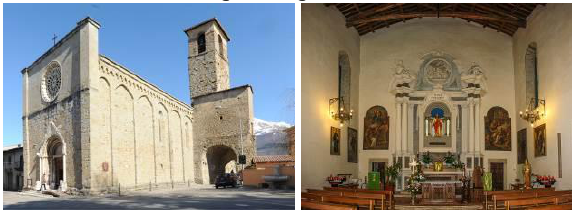
Figure 2. External (left) and internal (right) view of S. Agostino before the earthquakes